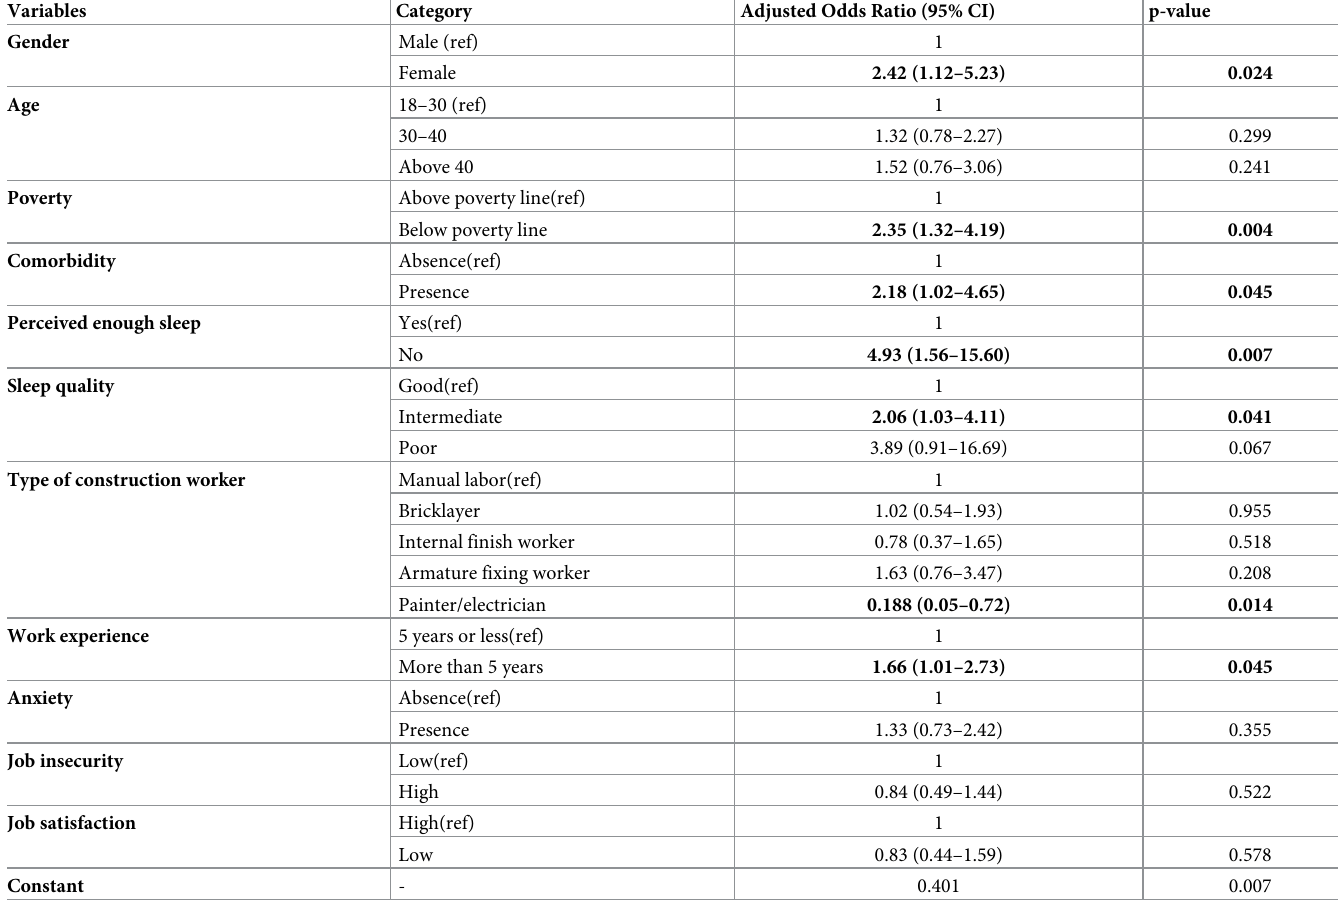
Table 4. Multivariate logistic regression analysis to determine independent predictor of LBP (N =